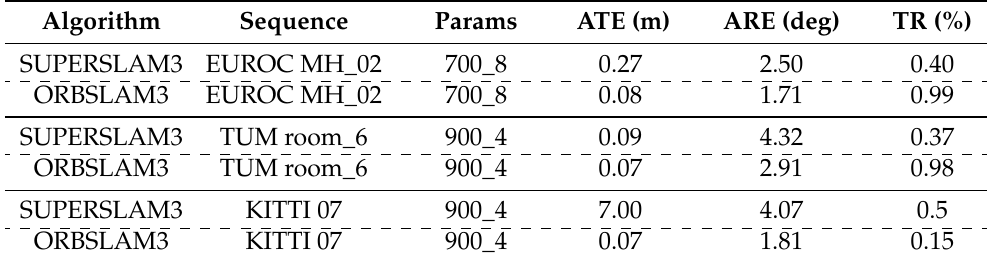
Table 4. Results of ORBSLAM3 and SUPERSLAM3 on a subset of blurred sequences. Algorithm Sequence